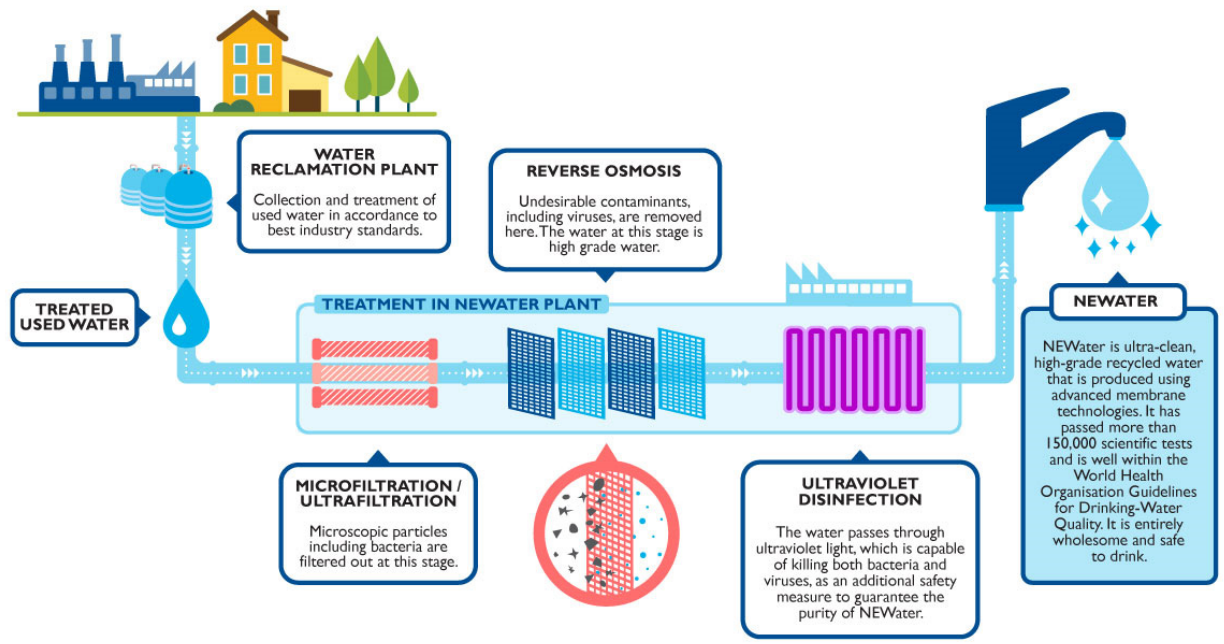
Figure 4. Schematic representation of the NEWater process to recycle treated used water into ultra-clean water [87]. Reprinted with permission from PUB, Singapore’s National Water Agency.